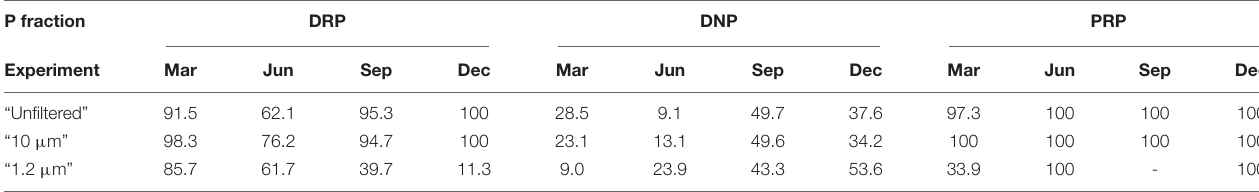
TABLE 6 | Relative bioavailability [%] of all treatments during the four experiments based on the respective median values. P fraction DRP DNP PRP Experiment